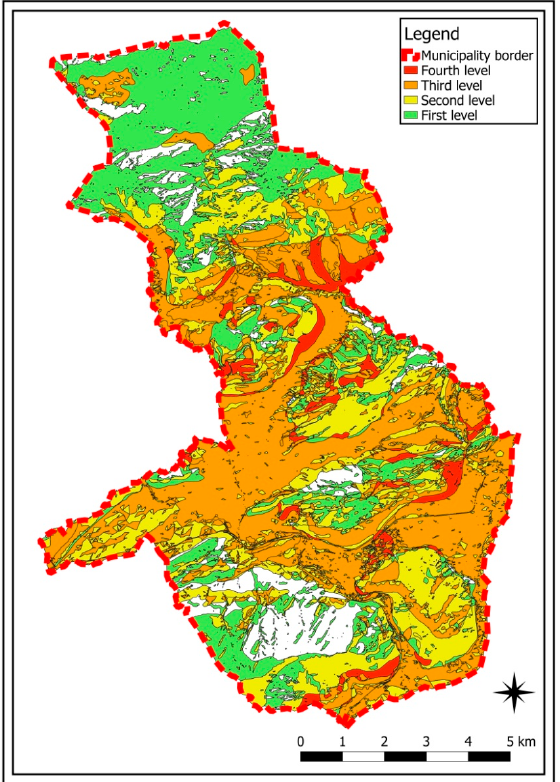
Figure 15. Susceptibility map for extreme precipitation events in the municipality of Feltre.